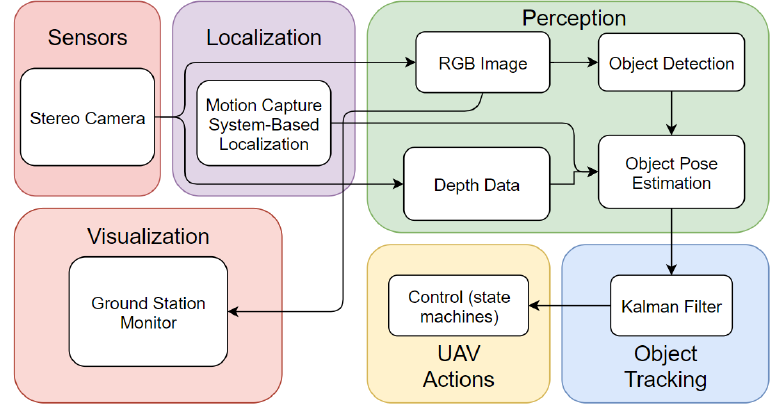
Figure 2. The software architecture of autonomous object tracking system.